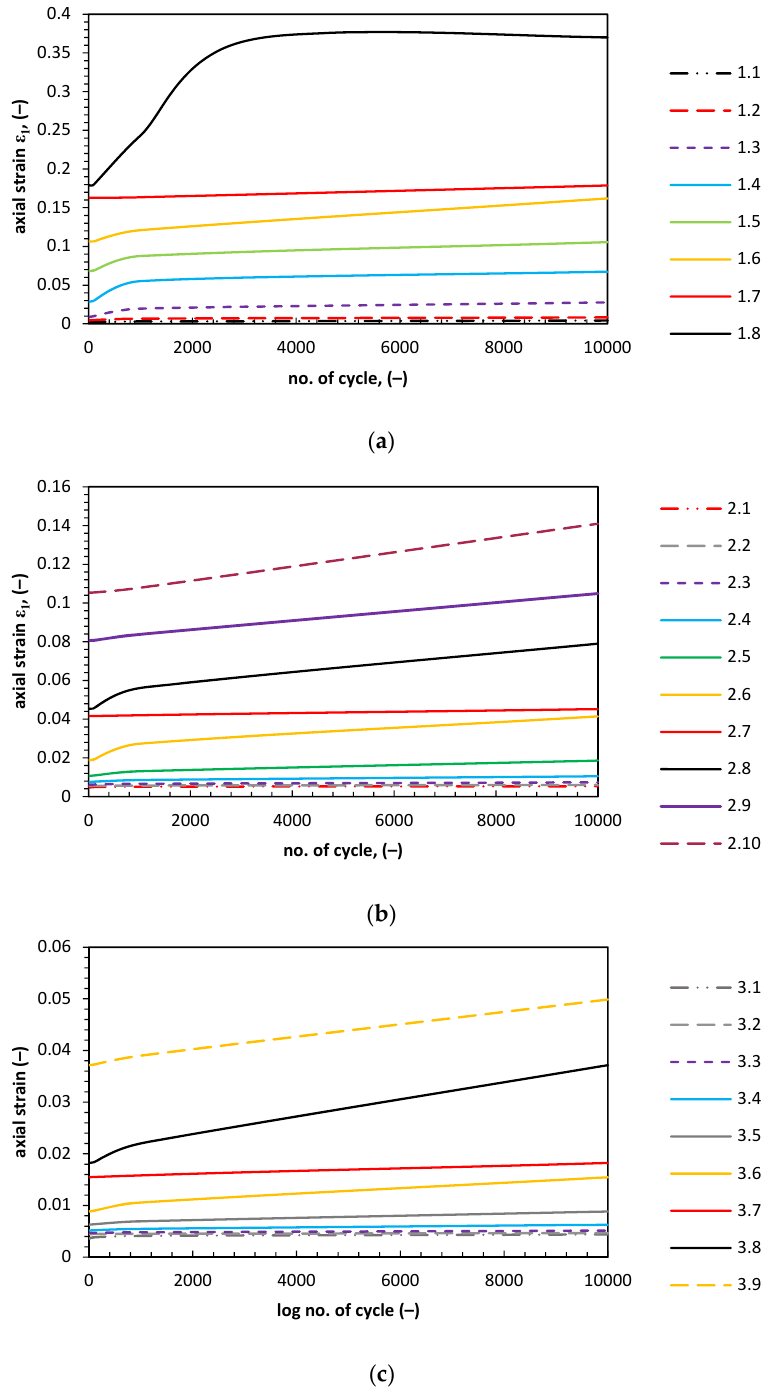
Figure 3. Axial strain ε 1 development during cyclic triaxial test for tests under ( a ) confining pressure σ ’ 3 equal to 45 kPa; ( b ) for tests under σ ’ 3 equal to 90 kPa; and ( c ) for tests under σ ’ 3 equal to 135 kPa.